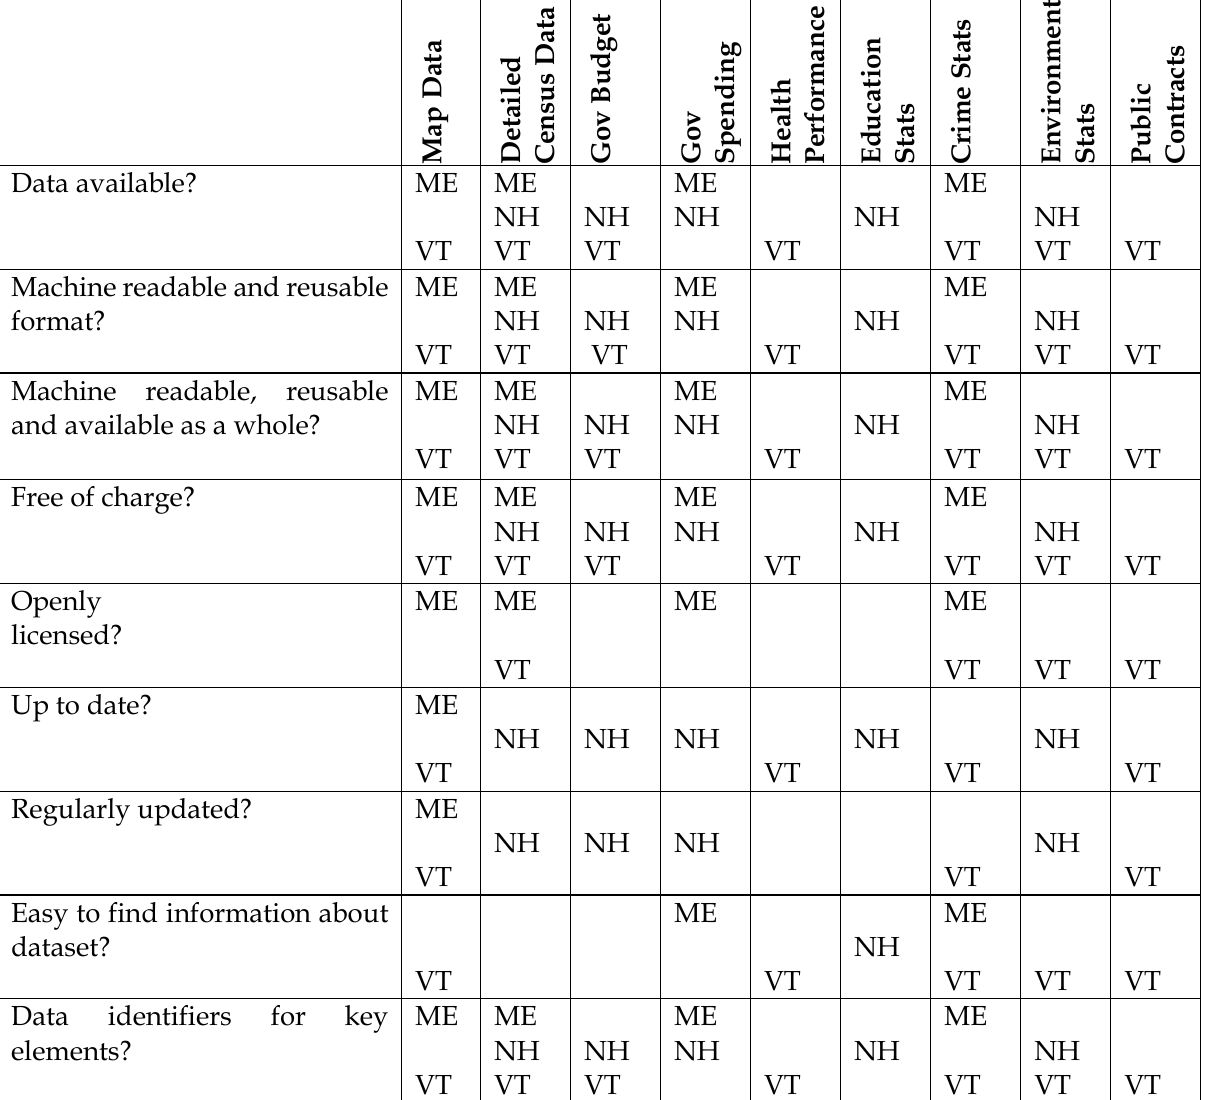
Table 2: Data availability comparison by state, based on ODB checklist